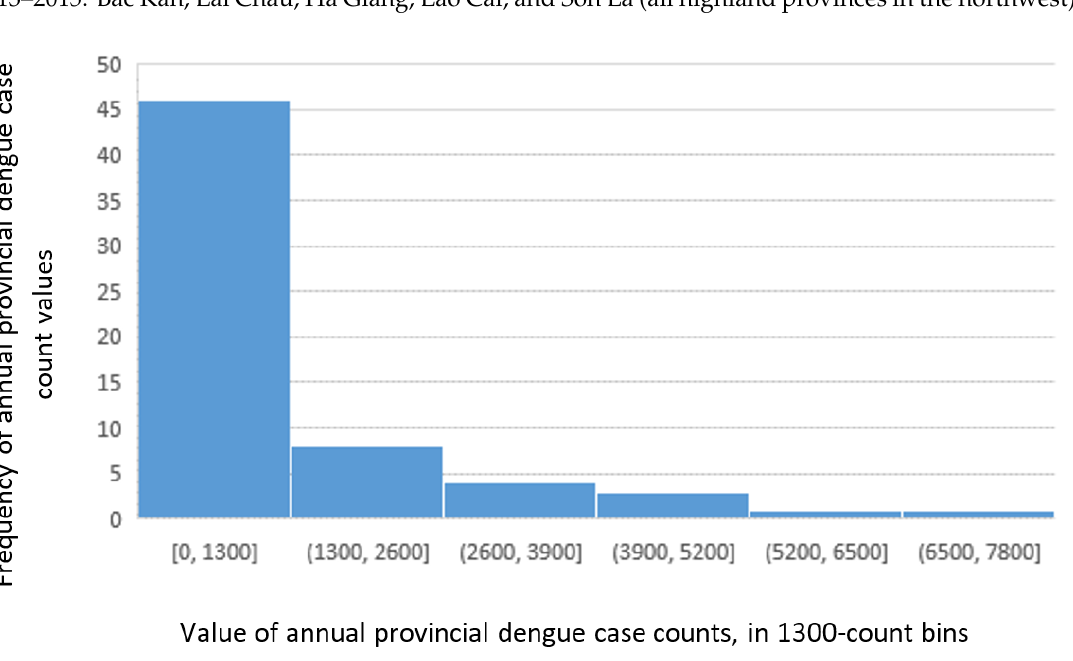
Figure 1. Histogram of dengue case counts per province-year in Vietnam, 2013–2015.